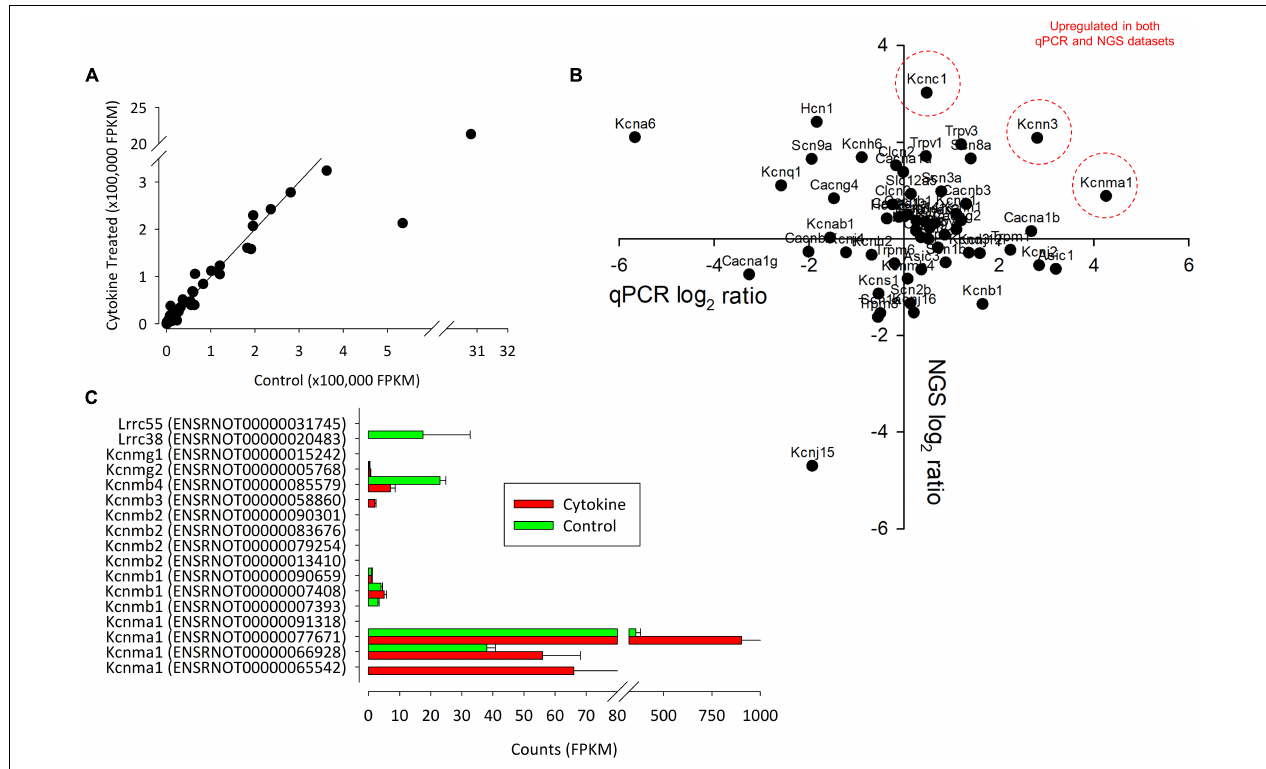
FIGURE 4 | The correlation between control and NGS expression data. (A) We found a strong correlation between control and treated (72 h of IL1 β + TNF α ) channel expression data. Each point represents the intersection of four control and four test values. In (B) , the correlation between qPCR ( (cid:49)(cid:49) Cts) and NGS ratio (FPKM values) are shown. Data suggest that there only a weak linear correlation between qPCR and NGS. P -value = 0.3. R = 0.29. n = 14 (eight animals for NGS and six animals for PCR). Genes that were upregulated in both datasets are indicated in red. (C) Summary of NGS expression of all known (rat) splice variants of Kcnma1 and associated Kcnmb